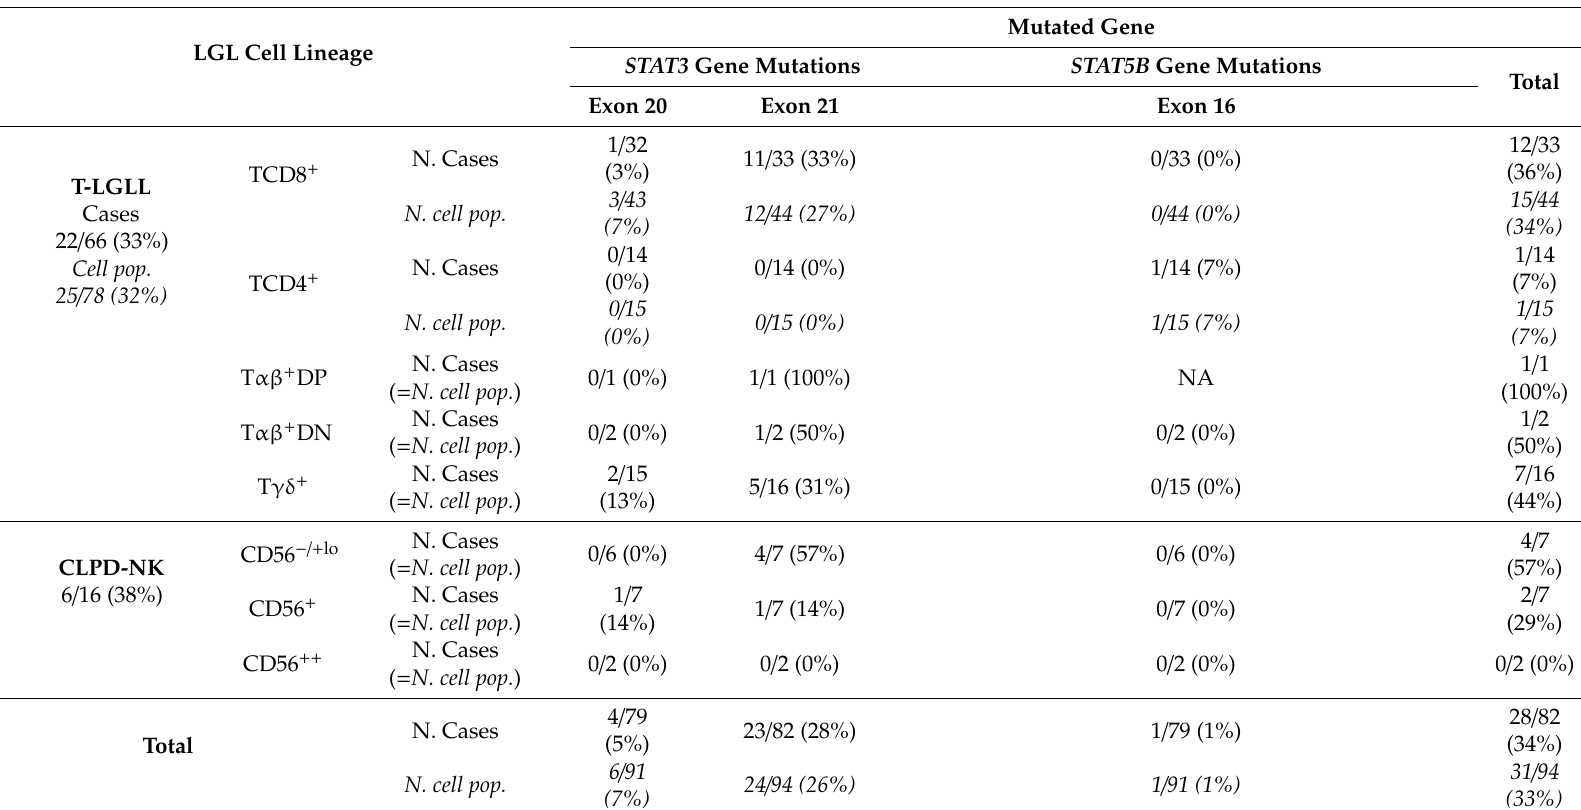
Table 1. Distribution of SH2 domain STAT3 and STAT5B gene mutations in LGLL patients and clonal T / NK-cell populations investigated in this study, grouped per disease